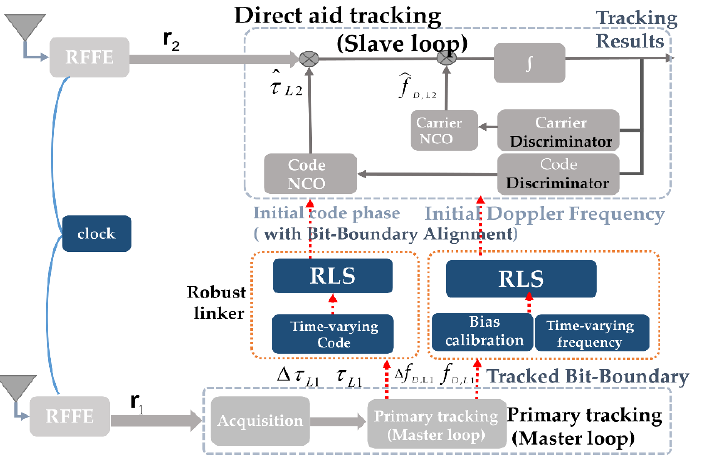
Figure 6. Algorithm block diagram of the proposed robust direct aid tracking scheme.